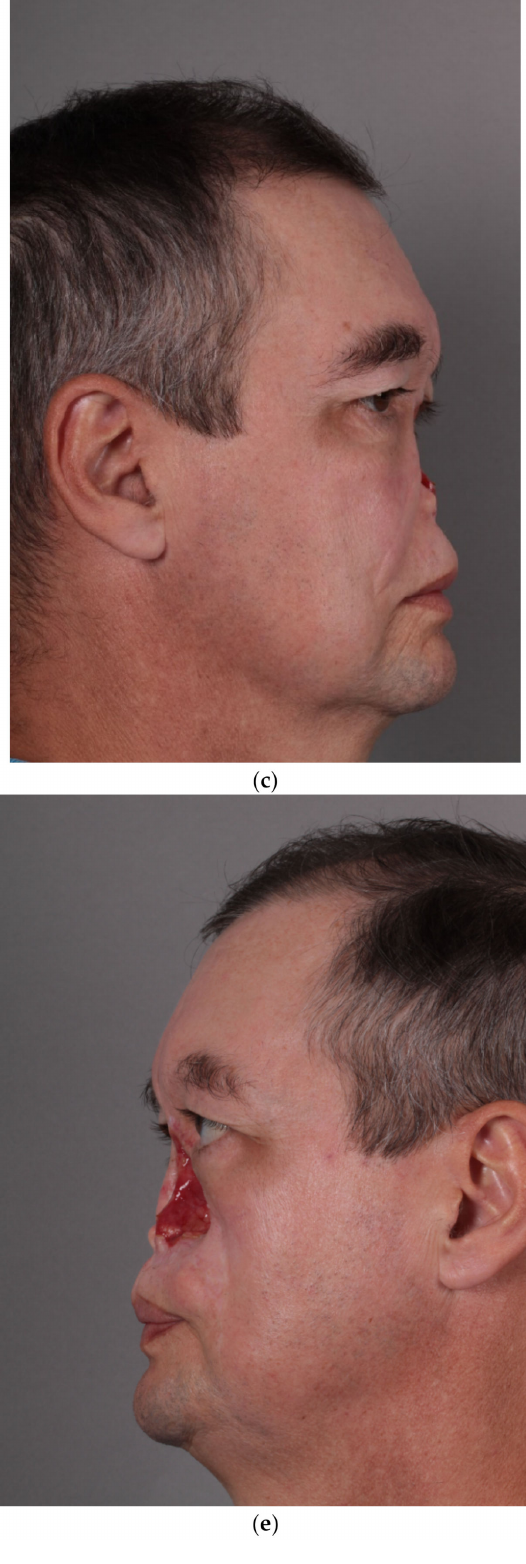
Figure 3. Patient after resection of squamous cell carcinoma of the nose, part of the left maxilla and cheek, and postoperative radiochemotherapy: ( a ) en face view; ( c ) right profile view; and ( e ) left profile view of the patient. Restorative facial prosthesis: ( b ) en face view; ( d ) right profile view; and ( f ) left profile view of the